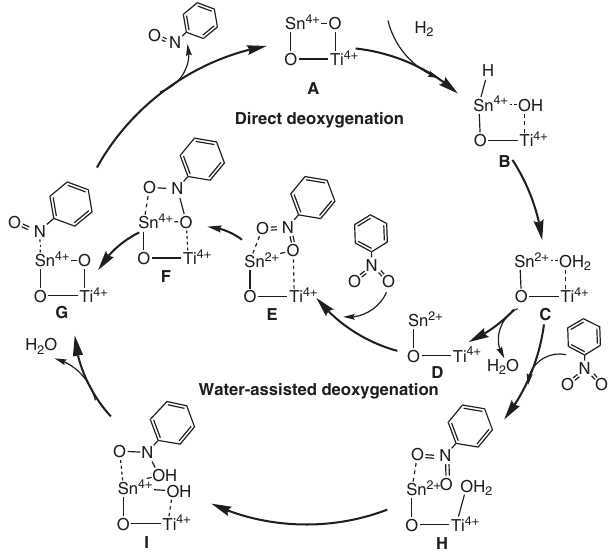
Fig. 3 Catalytic cycle. Proposed mechanism of catalytic deoxygenation of nitrobenzene on single Sn-substituted TiO 2